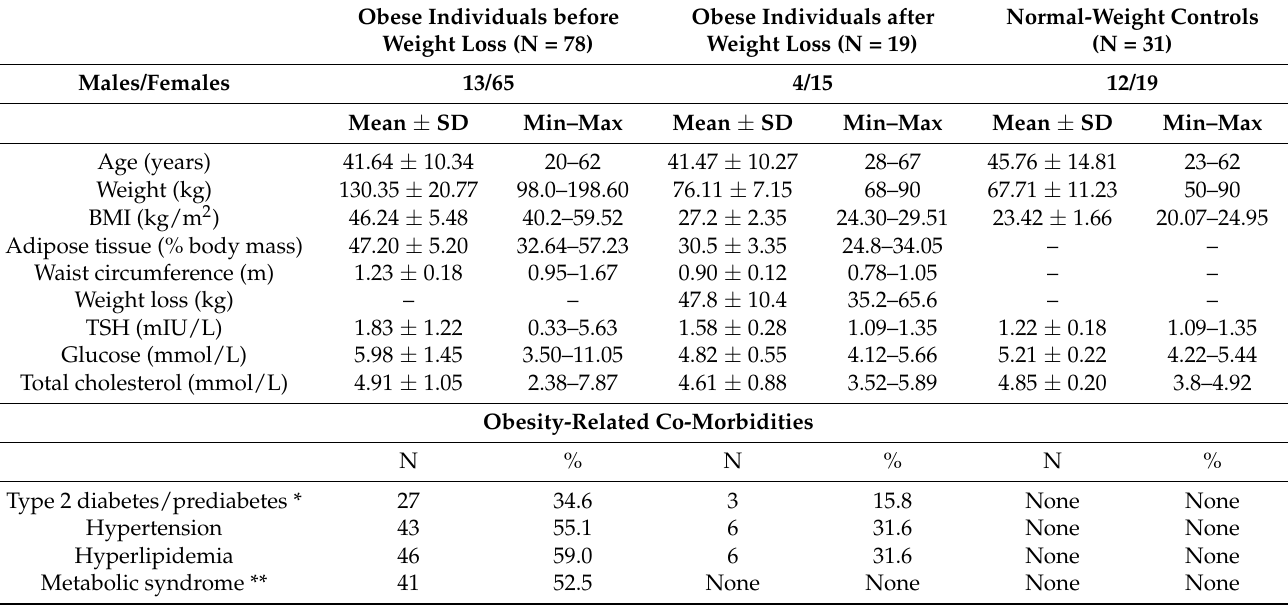
Table 1. Selected clinical and biochemical parameters of the study participants. Obese Individuals before Weight Loss (N = 78)